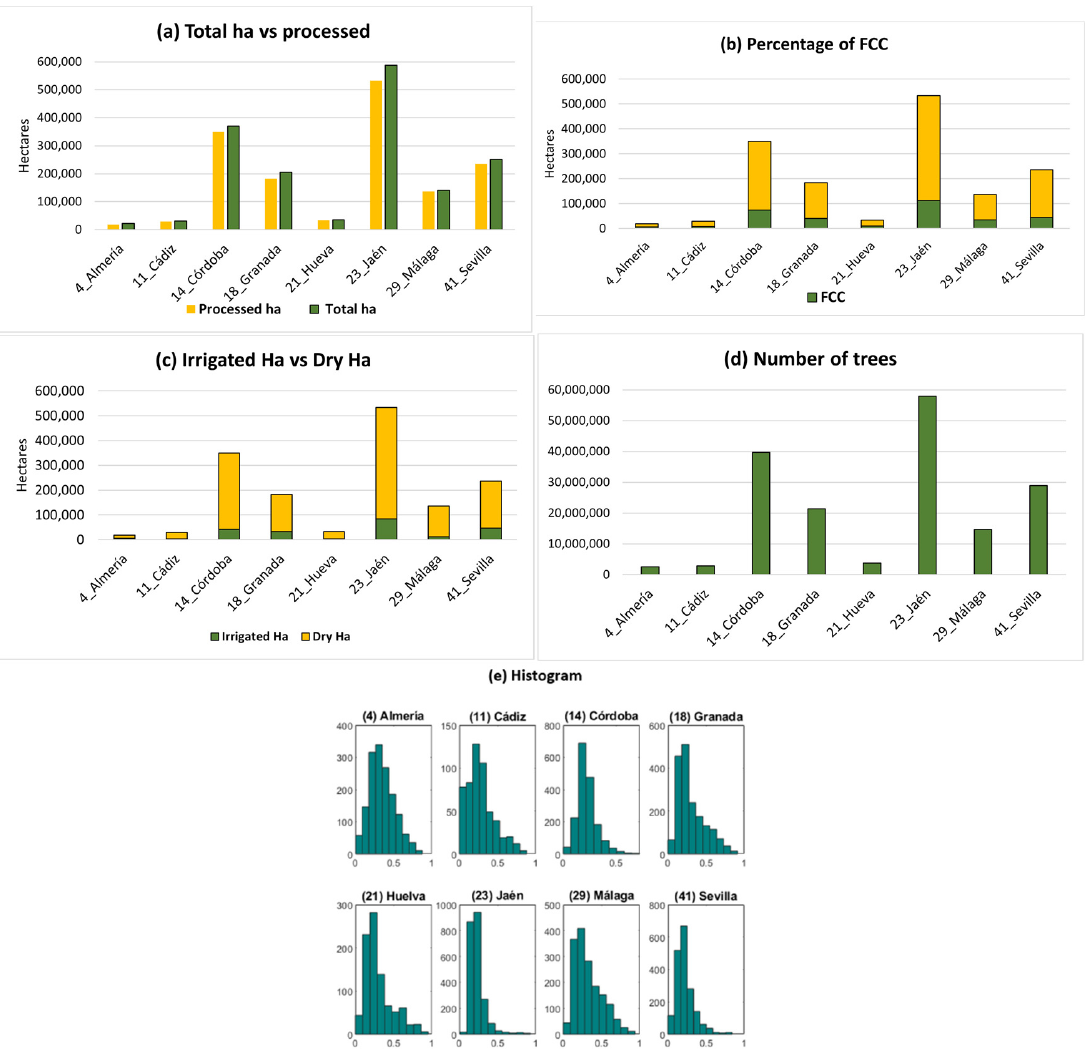
Figure 10. ( a ) Percentage of ha processed by province; ( b ) Percentage of FCC obtained by province; ( c ) Rainfed ha vs. irrigated ha by province; ( d ) Number of trees per province; ( e ) Histogram.